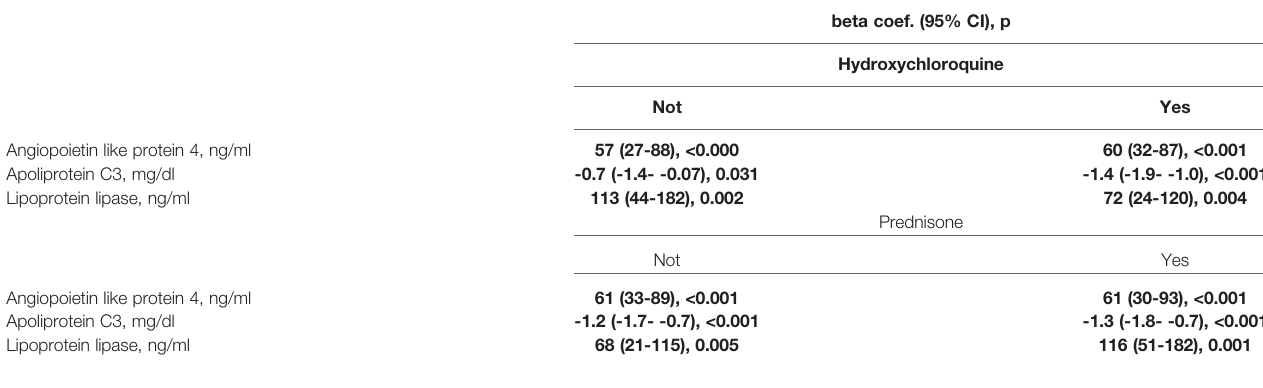
TABLE 4 | Multivariable analysis of the differences in angiopoietin like protein 4, apolipoprotein C3 and lipoprotein lipase serum levels between controls and SLE patients divided by the intake of hydroxycloroquine and prednisone.